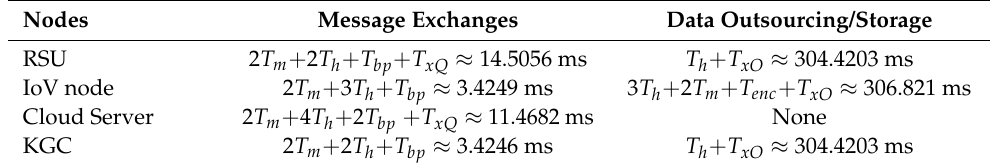
Table 2. Computational Cost